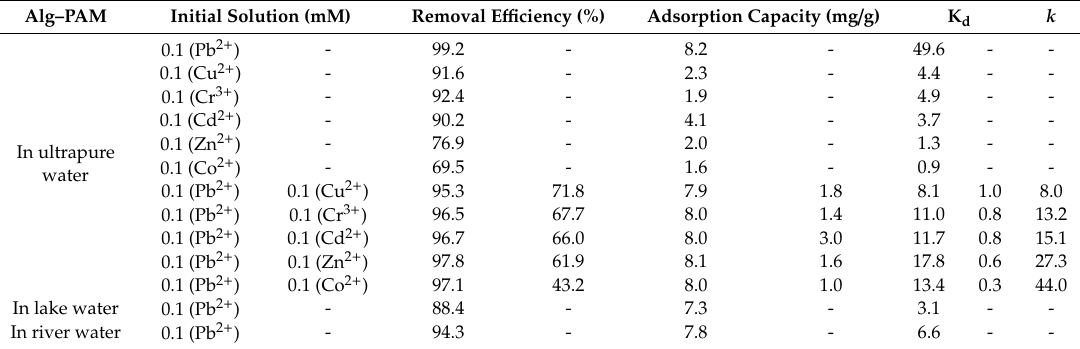
Table 1. Adsorption ability of the sodium alginate-polyacrylamide (Alg–PAM) for different metal